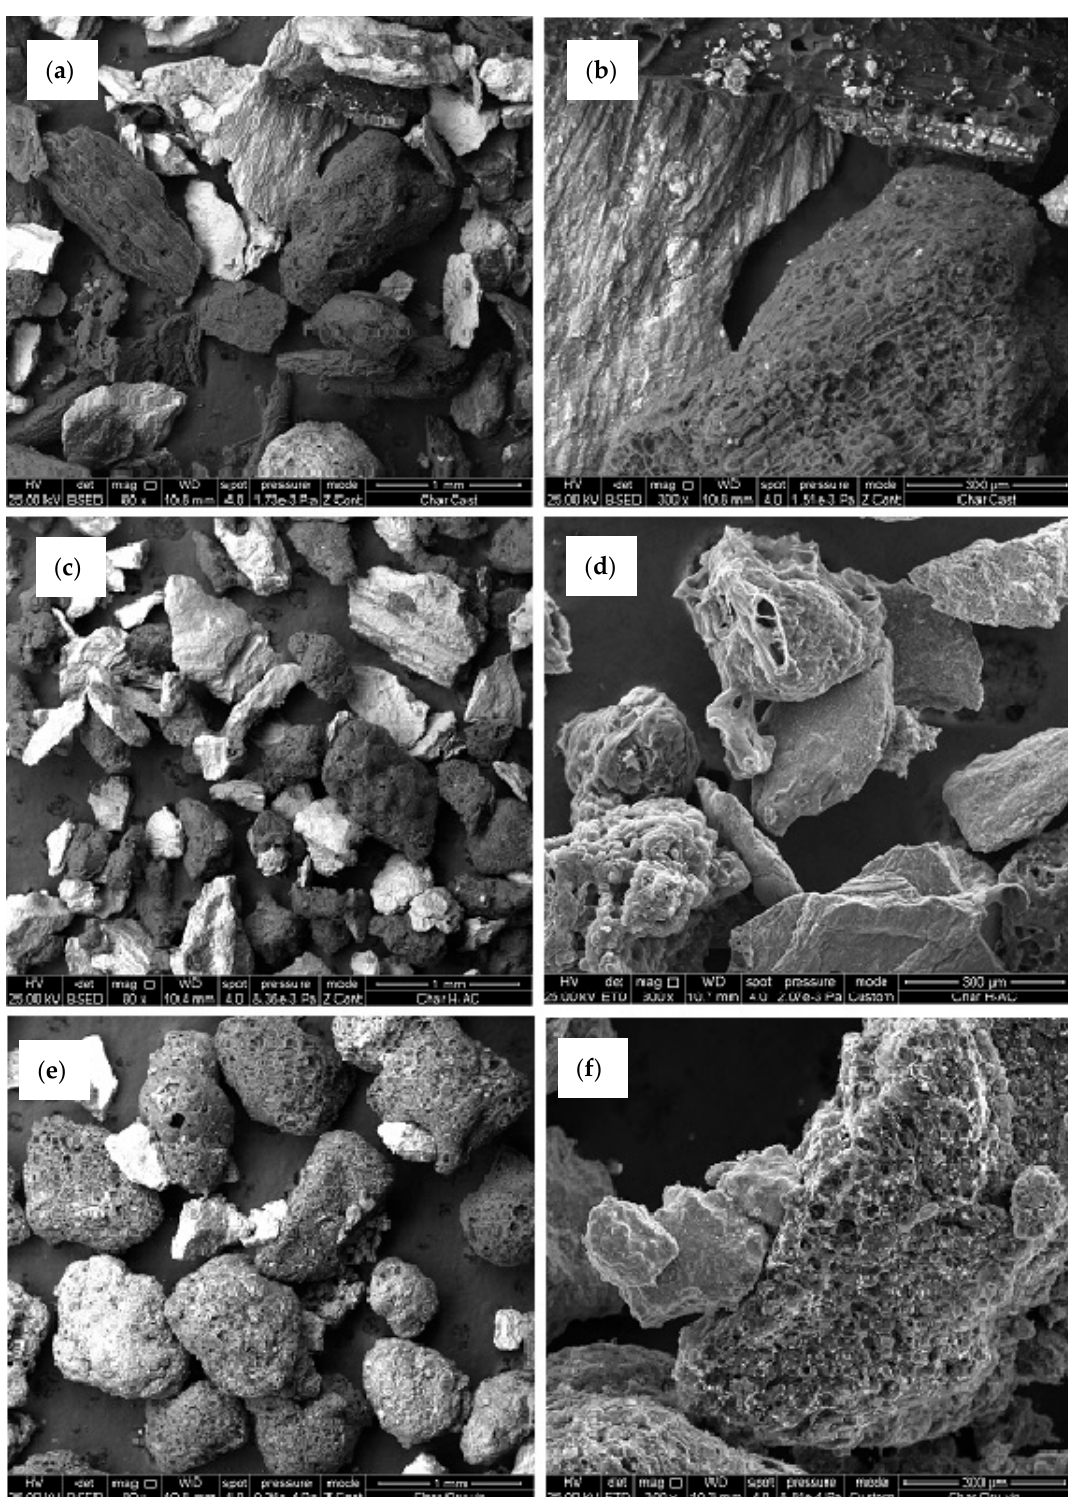
Figure 7. SEM images of ( a , b ) CHET; ( c , d ) OS and ( e , f ) GP chars at ×80 and ×300 magnifications.